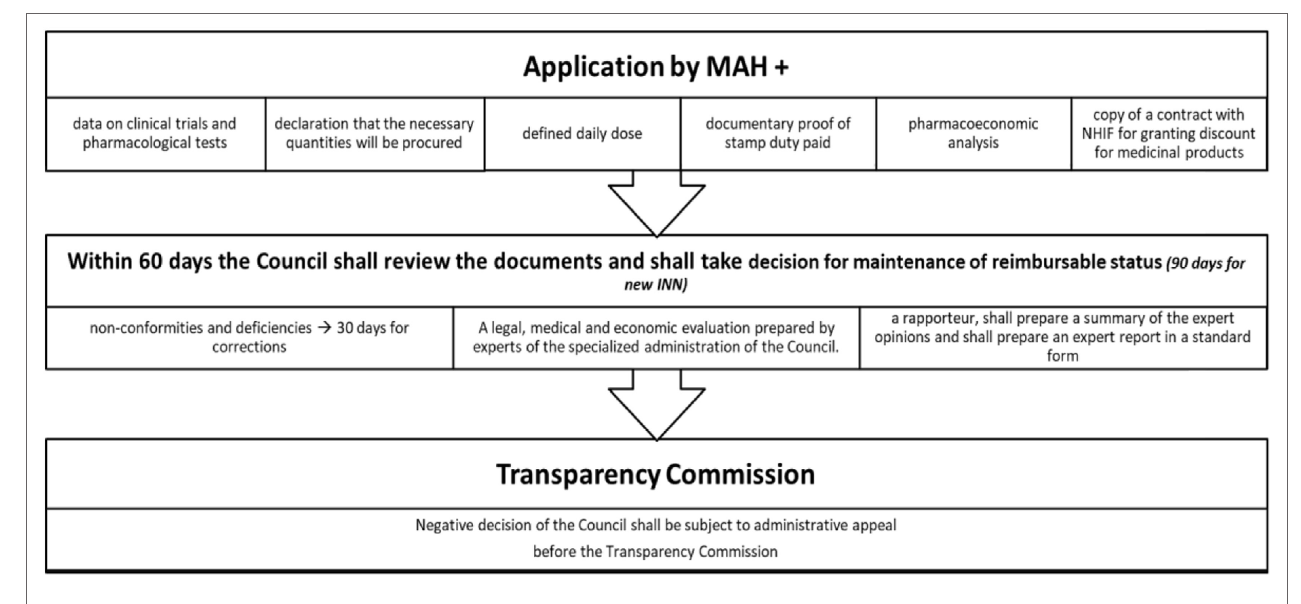
Figure 2 | Procedure for inclusion of MPs in PDL. Abbreviations: MPs, medicinal products; PDL, positive drug